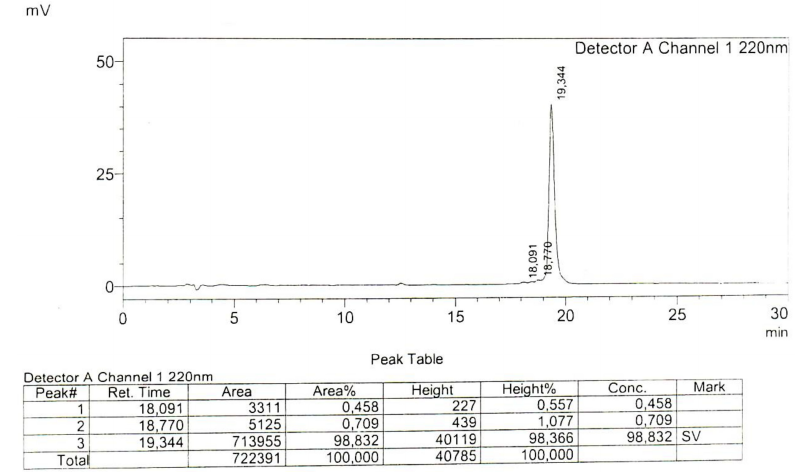
Figure A2. Analysis by high-performance liquid chromatography (HPLC) of StigA25 peptide.